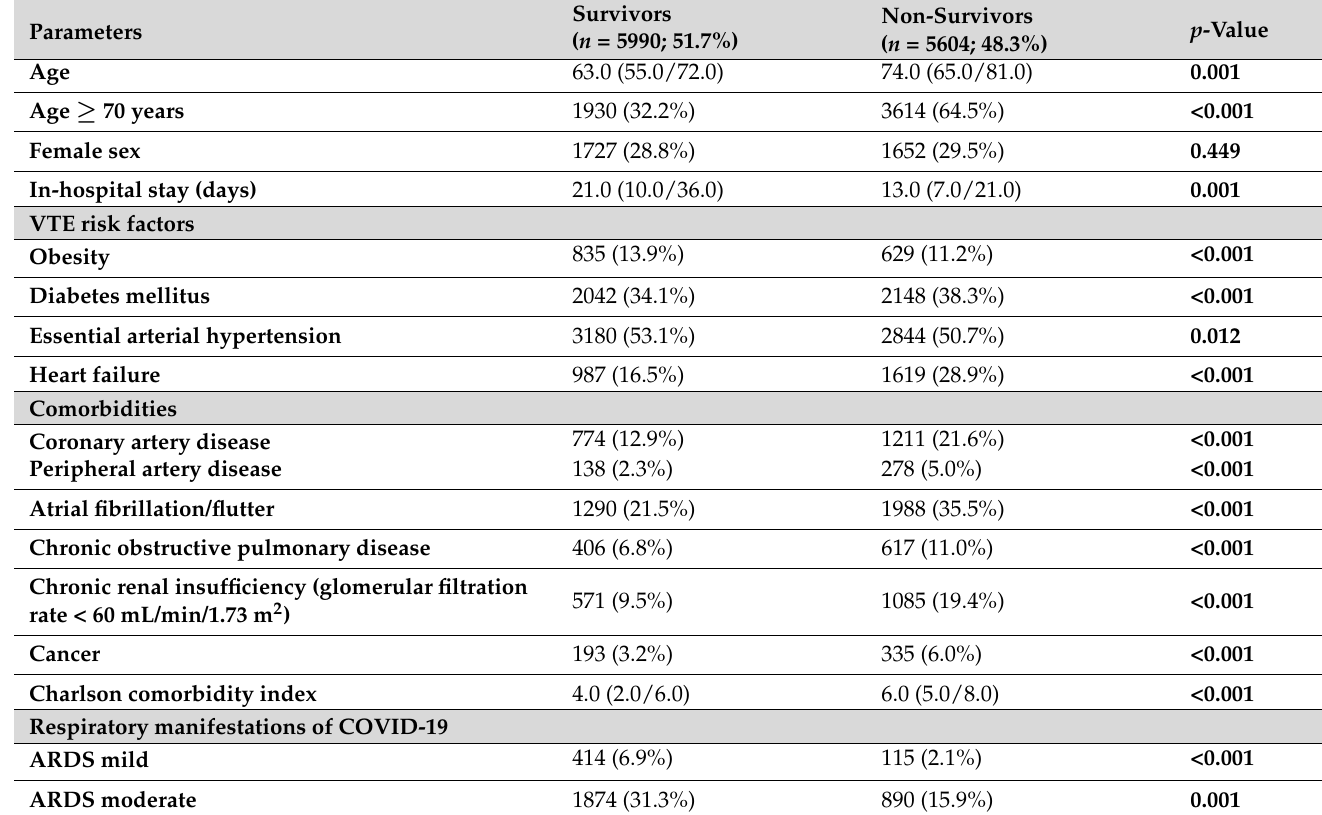
Table 2. Characteristics, medical history, presentation and adverse in-hospital events of the 11,594 hospitalized patients with confirmed COVID-19 and concomitant acute respiratory distress syndrome (ARDS) in Germany in 2020, stratified for the presence of in-hospital death.